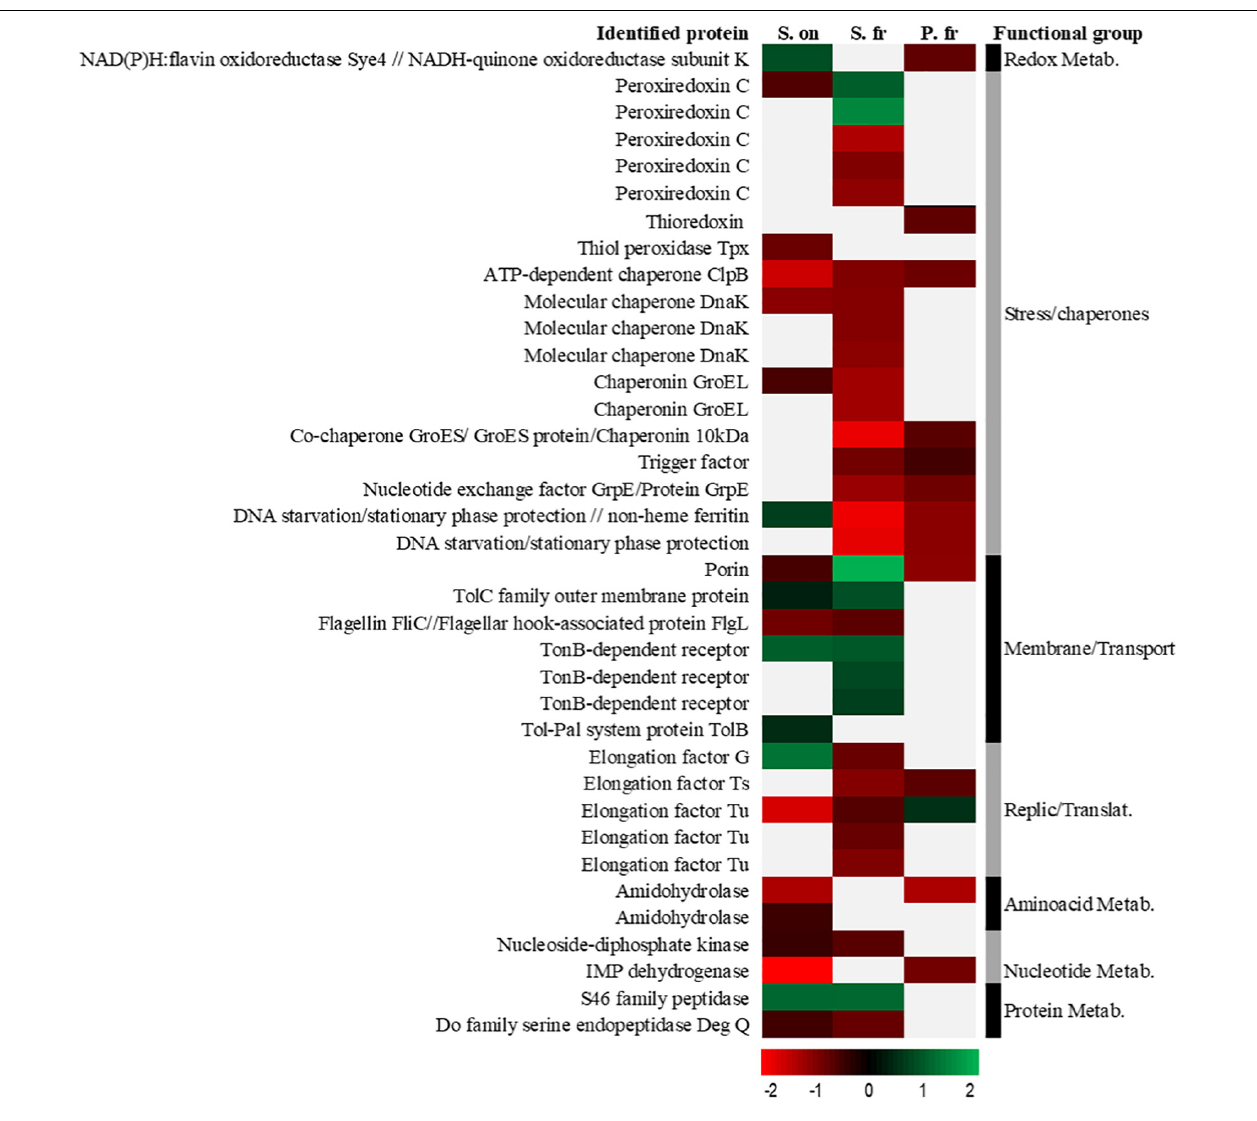
FIGURE 3 | A heat map of ratios from 2D-DIGE experiments of the proteins over-synthesized at 30 (red) and 4 ◦ C (green) found in common in at least two of the three studied bacteria. The color and intensity of each protein are calculated as a function of the logarithm based on 10 of the value of its 4/30 ratio obtained in the 2D-DIGE experiment so that values closer to –2 indicate higher ratios in proteins whose synthesis has been increased to 30 ◦ C and closer to 2 higher ratios in proteins whose synthesis has been increased to 4 ◦ C. The gray/white color indicates the absence of identification of that specific protein in the corresponding species. “ S. on ” indicates Shewanella oneidensis , “ S. fr ” indicates Shewanella frigidimarina and “ P. fr ” indicates Psychrobacter frigidicola